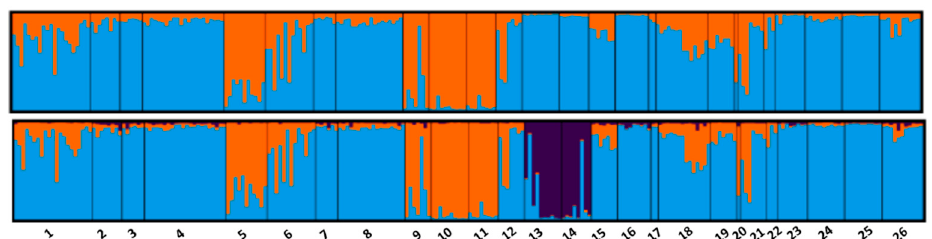
Figure 4. Bar plot of K2 and K3 results (individual membership coefficient) of STRUCTURE using the